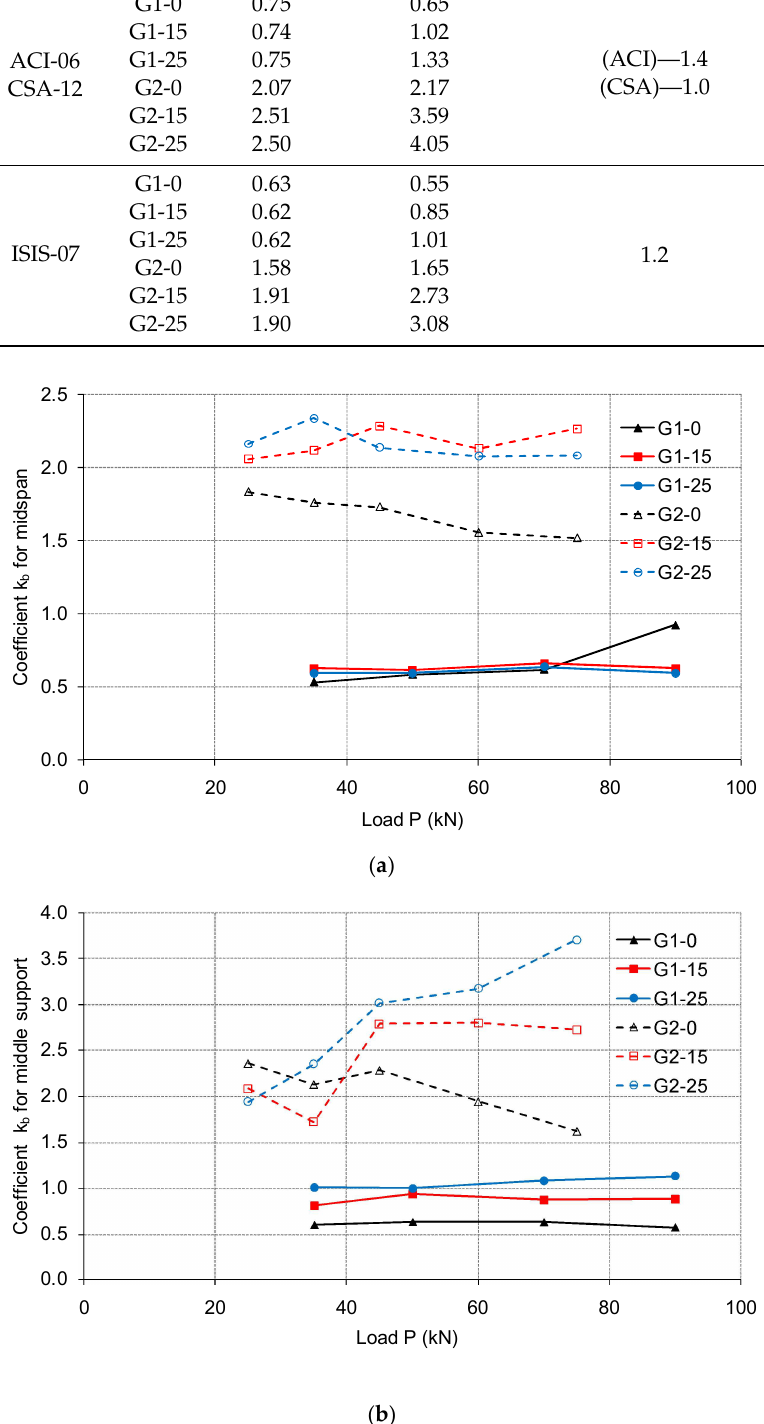
Figure 10. Bond-dependent coefficient k b for different load levels of tested beams: ( a ) midspan; ( b ) middle support .